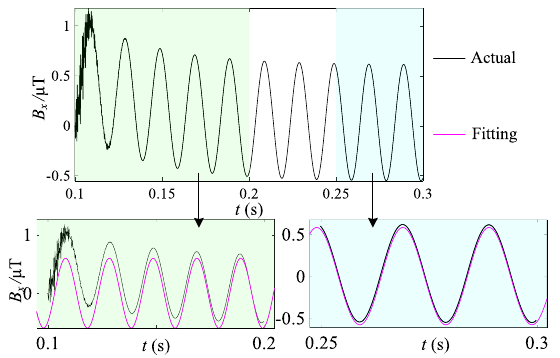
Fig. 13 Fitting effect of B x under different data windows